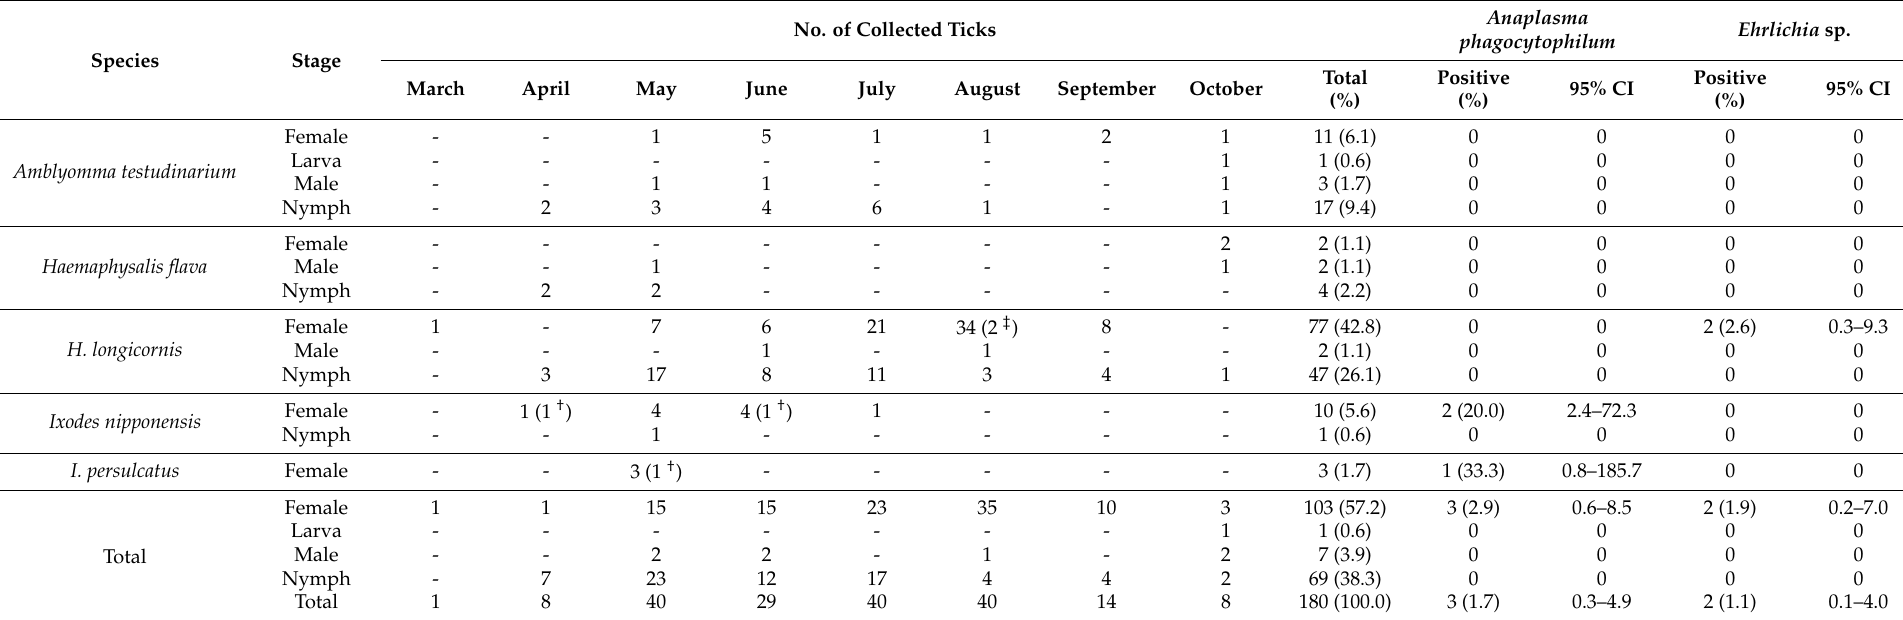
Table 2. Seasonal distribution of human-biting ticks and pathogen prevalence in the Republic of Korea, March–October, 2020.